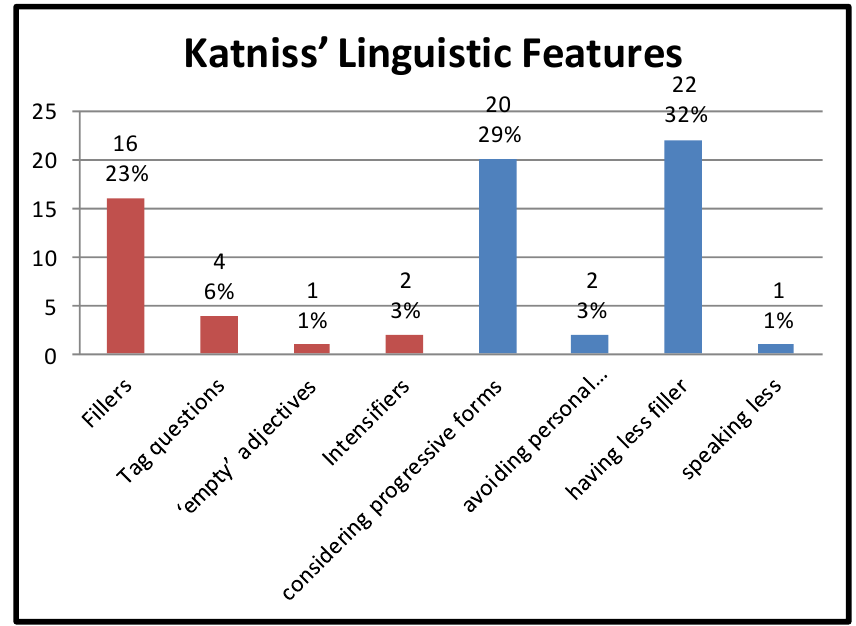
Figure 2: The Frequency and Percentage of Katniss’ Linguistic